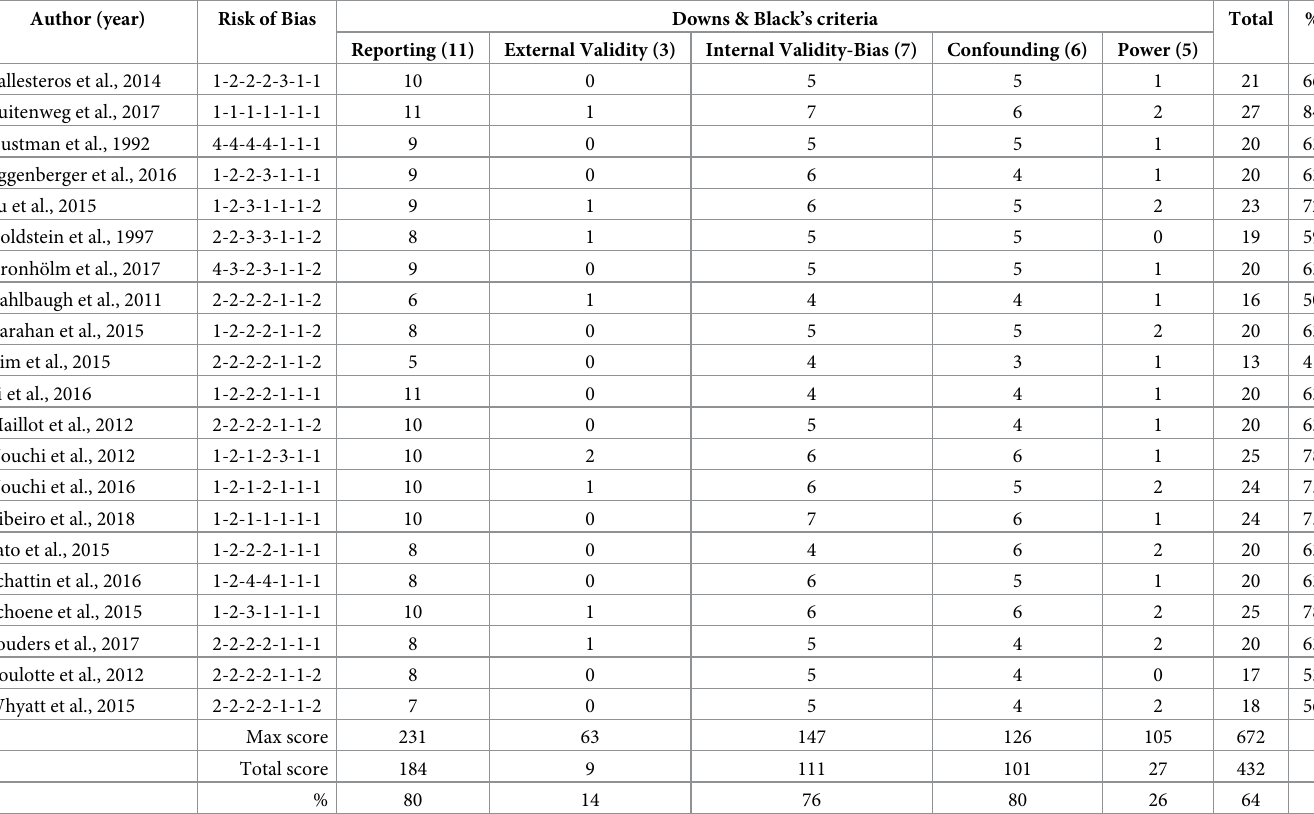
Table 2. Methodological quality of included studies (Risk of bias / Downs & Black’s criteria).